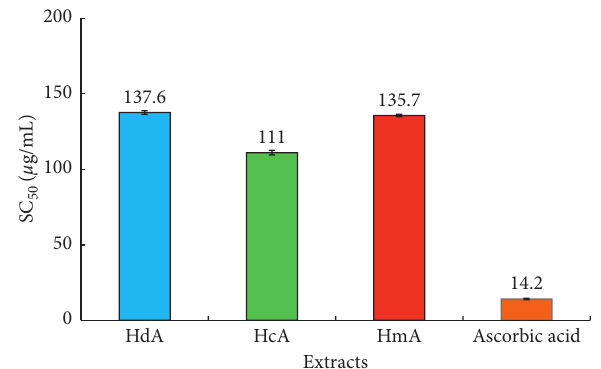
Figure 3: SC 50 of antioxidant activity of Hibiscus deflersii (HdA), H. micranthus (HmA), and H. calyphyllus